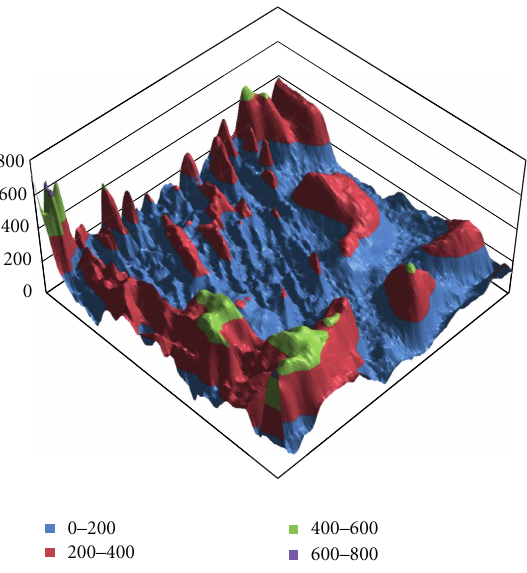
Figure 3: 3D SAD map for a 1080 p sun flower frame.